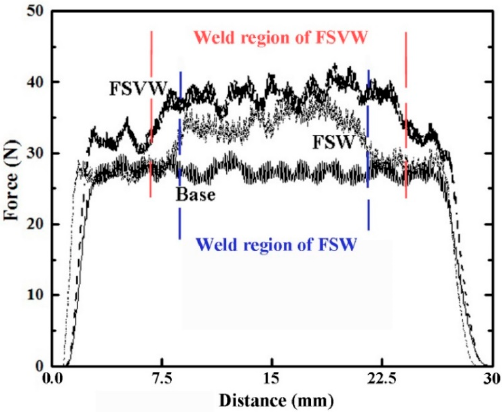
Figure 11. Force values measured during cutting process for different samples, and FS- and FSV-welded samples, as well as the base material.